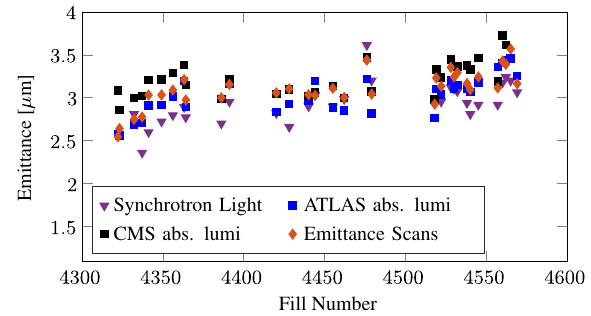
FIG. 8. The average convoluted emittances at the start of collisions in 2015 proton physics operation (only fills with emittance scans are shown).